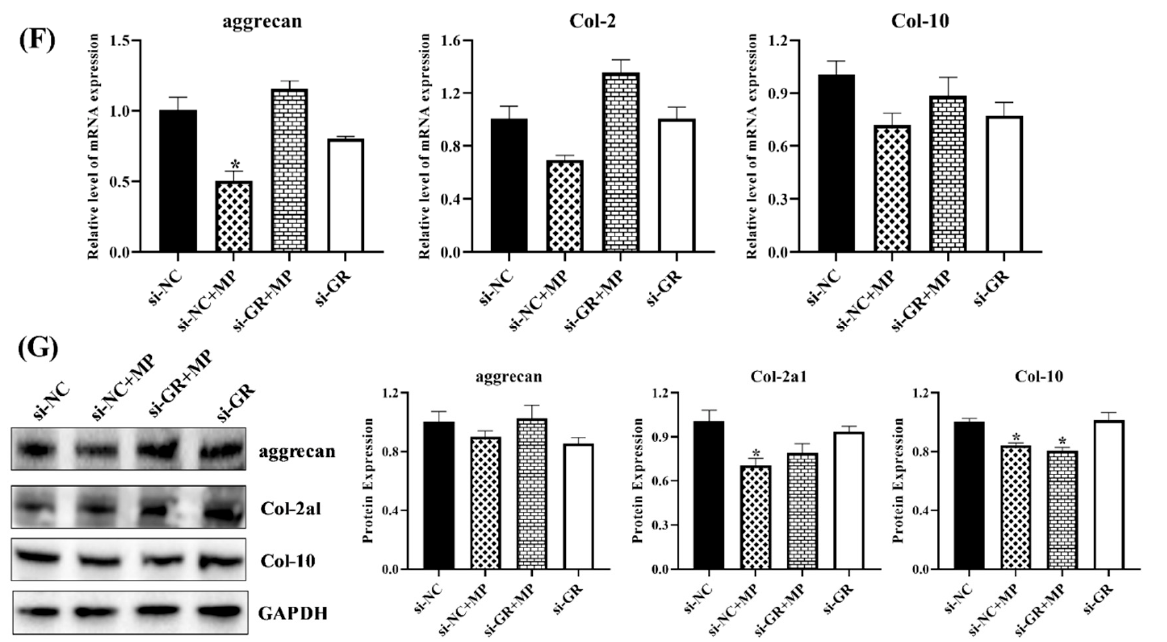
Figure 9. The expressions of related factors in chondrocytes with siGR-treatment. ( A ) The mRNA expressions of GR and HIF-1 α in chondrocytes. ( B ) The mRNA expressions of GR and the HIF pathway in chondrocytes. ( C ) The protein expressions of GR, HIF-1 α , and VHL in chondrocytes. ( D ) The mRNA expressions of homeostasis-related genes in chondrocytes with different treatments. ( E ) The protein expressions of homeostasis-related factors in chondrocytes. ( F ) The mRNA expressions of ECM in chondrocytes. ( G ) The protein expressions of ECM in chondrocytes. Here, * p < 0.05 vs. control group.